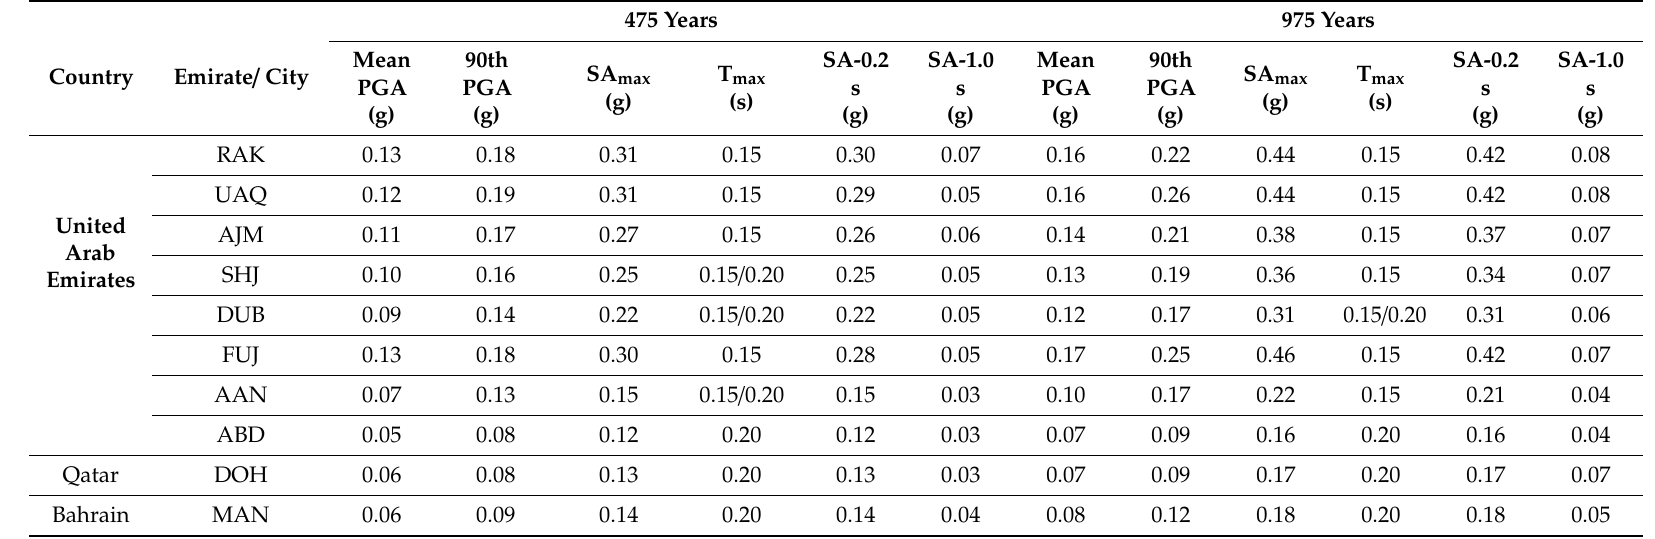
Table 5. Obtained seismic hazard values for the selected emirates and cities, for return periods of 475 and 975 years [PGA: peak ground acceleration; SA max : maximum spectral acceleration; T max : spectral period related to SA max ].